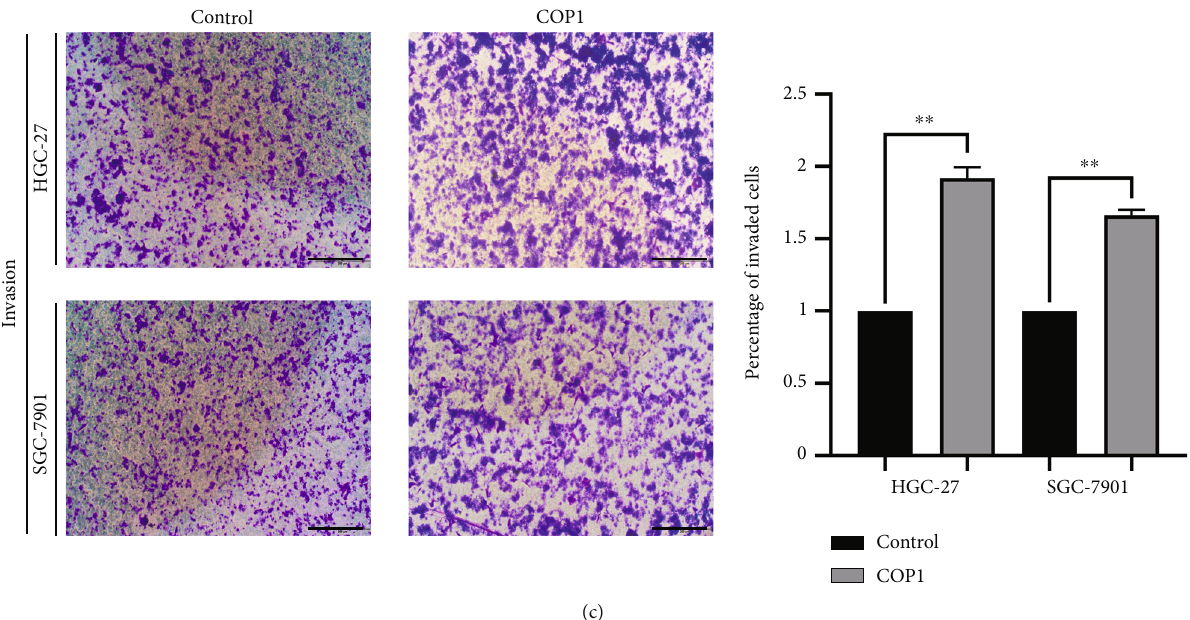
Figure 3: COP1 over-expression precipitated the proliferation and migration of GC cells. (a) COP1 over-expression promoted the colon formation numbers of GC cells; (b and c) COP1 over-expression signi fi cantly increased the migration and invasion of GC cells. Bar=200 μ m. * P < 0 : 05 , ** P < 0 : 01 , *** P < 0 : 001